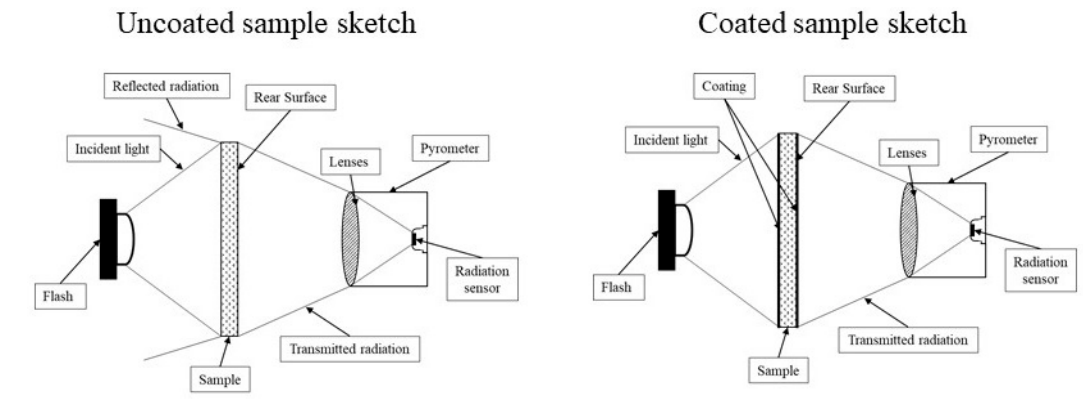
Figure 2. Sketches of the experiments.